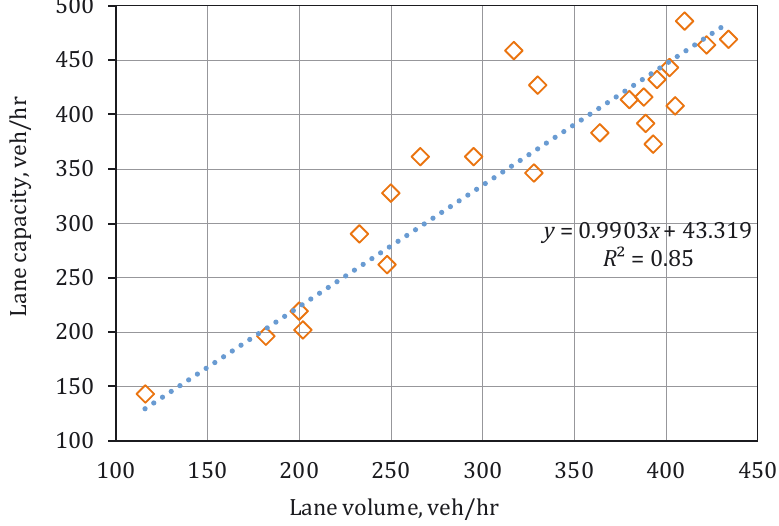
Figure 5. The relation between volume ( v ) and capacity ( c ) values on the examined intersection leg lanes